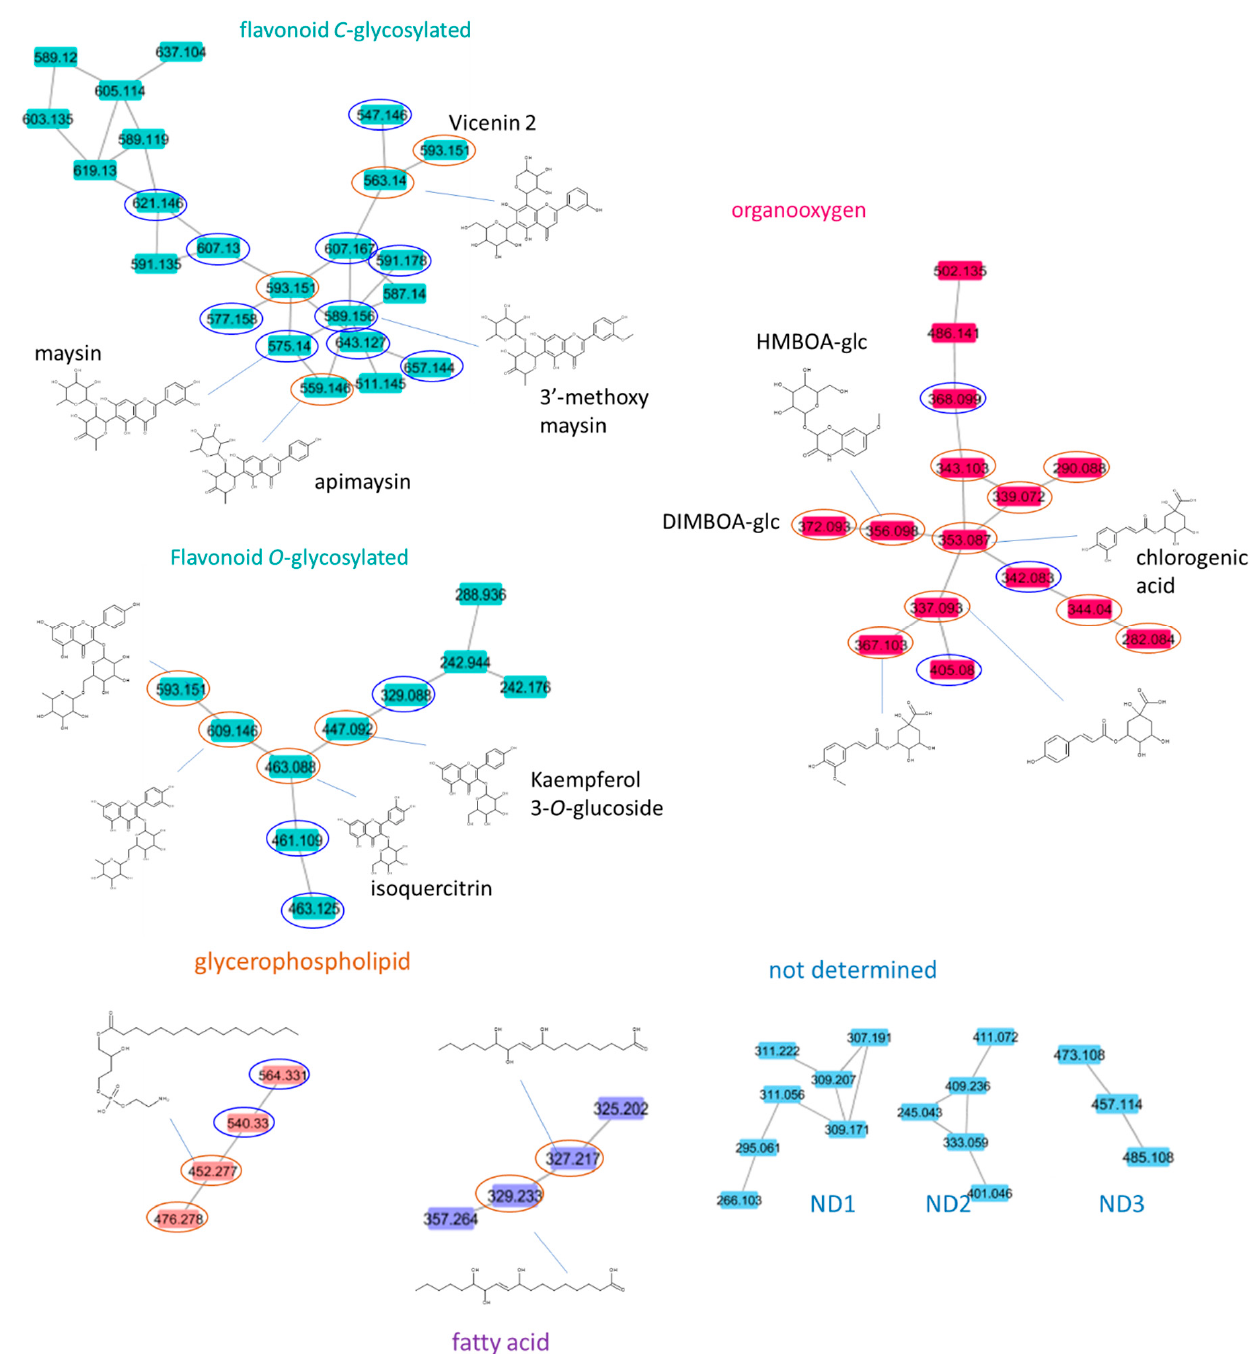
Figure 3. Representation of molecular networking applied to UHPLC/QT of MS/MS data from corn silk extract using electrospray ionization in the negative mode, with coloration based on the chemical class (MS2LDA), and identification of certain nodes via the GNPS library (red circles) and the proposition of structures (blue circles).